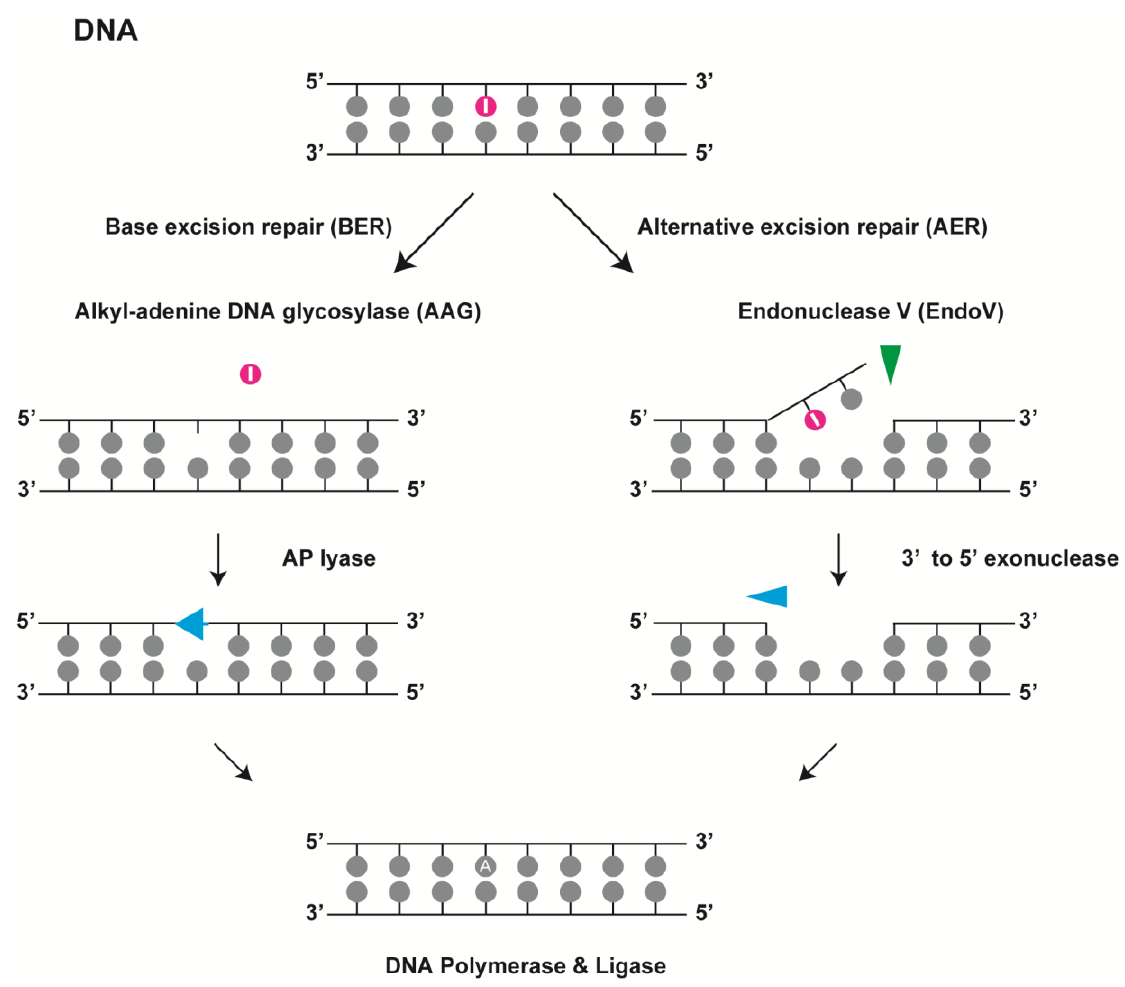
Figure 3. Endonuclease V in DNA repair. Deoxyinosine in DNA is repaired by alkyl-adenine DNA glycosylase (AAG) in the base excision repair (BER) pathway and by endonuclease V (EndoV) in the alternative excision repair (AER) pathway. EndoV hydrolyses the second phosphodiester bond located 3' to deoxyinosine in the DNA